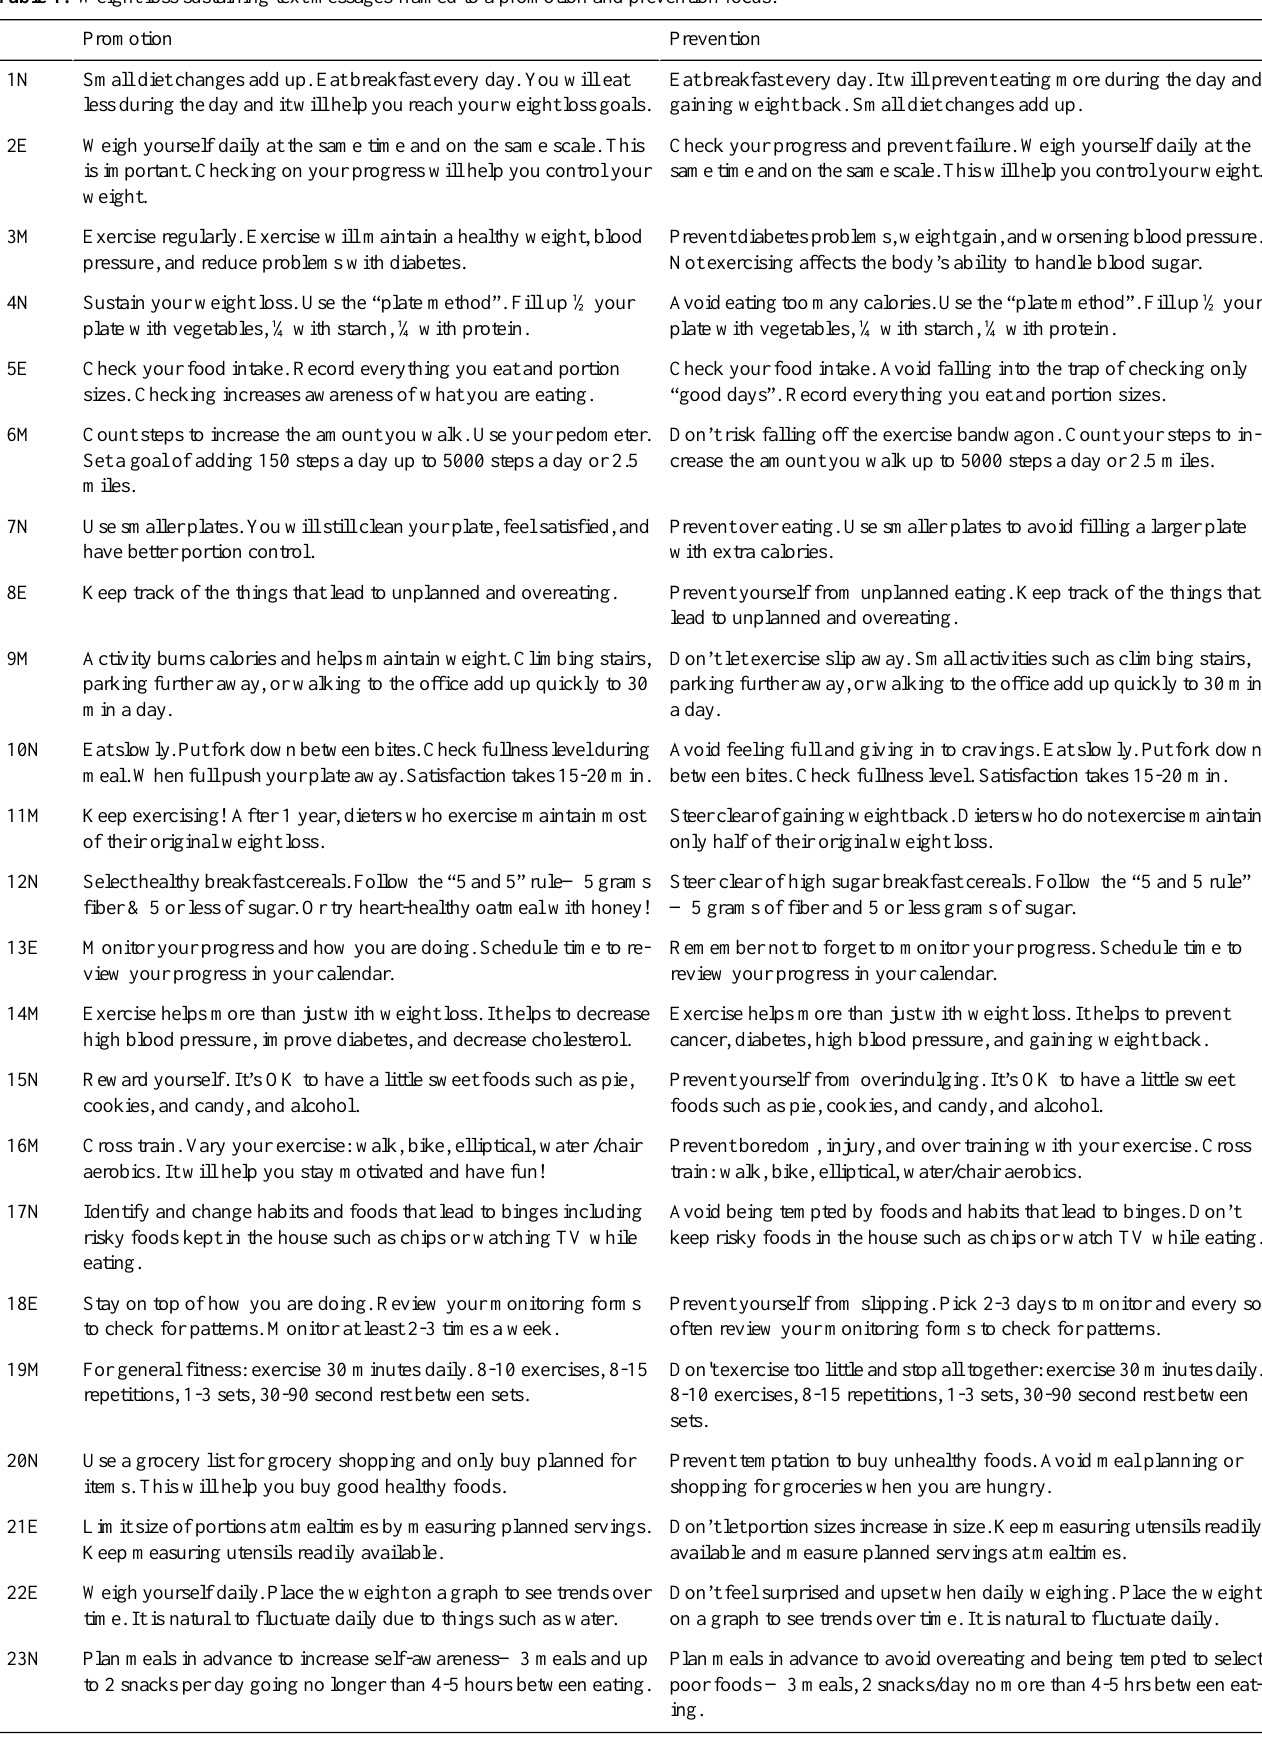
Table 1. Weight loss sustaining text messages framed to a promotion and prevention focus. a